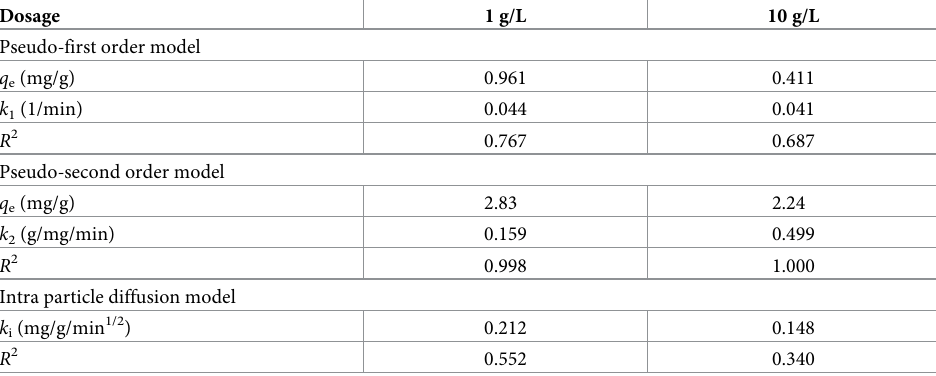
Table 2. Parameters of the kinetics models for fluoride adsorption using metaettringite at solid–liquid ratios of 1 and 10 g/L.